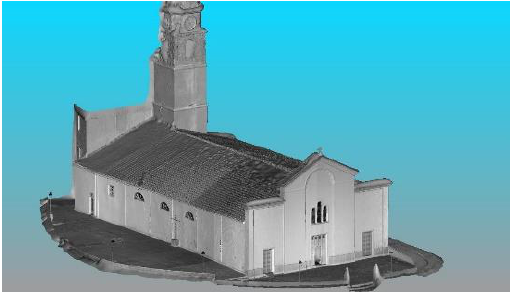
Figure 6 . Presbytery post removal with opening